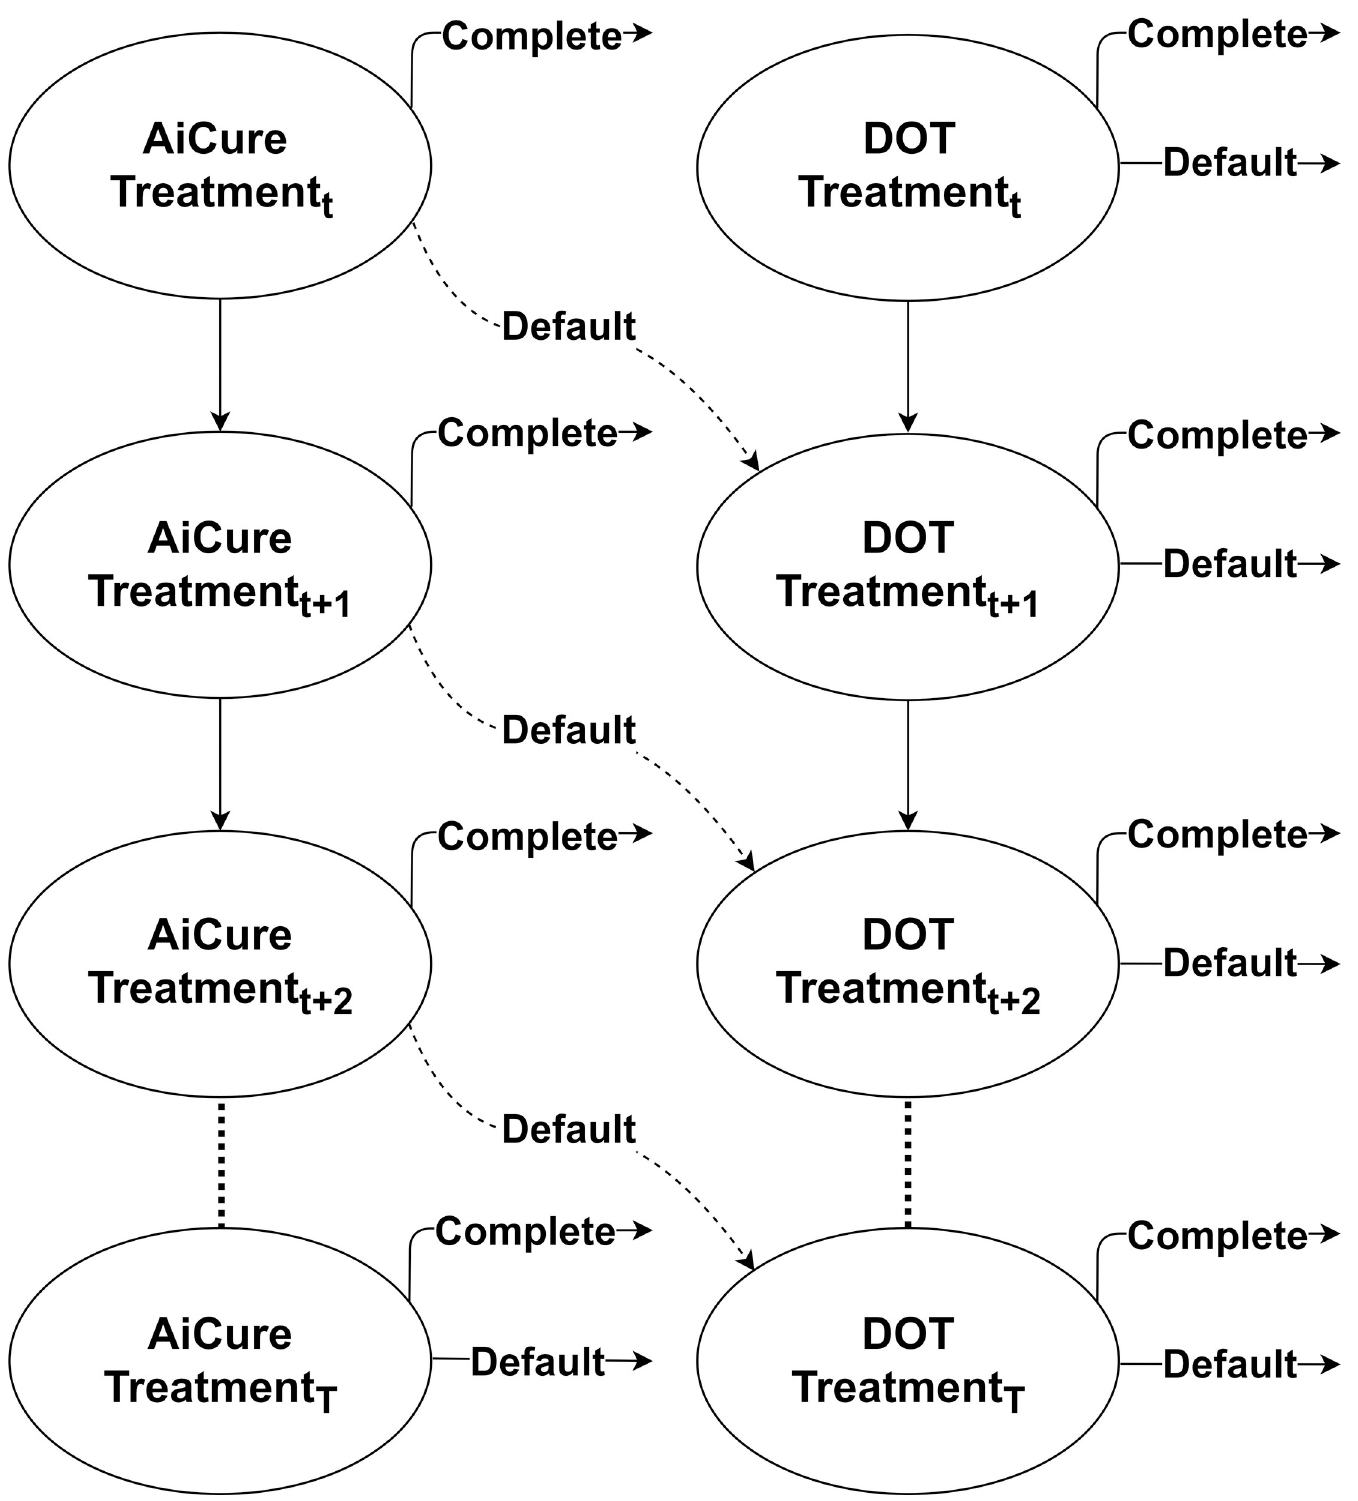
Fig 2. Markov state transition model for AiCure and DOT arms. AiCure patients (left) could default to DOT treatment (right). DOT directly observed therapy.